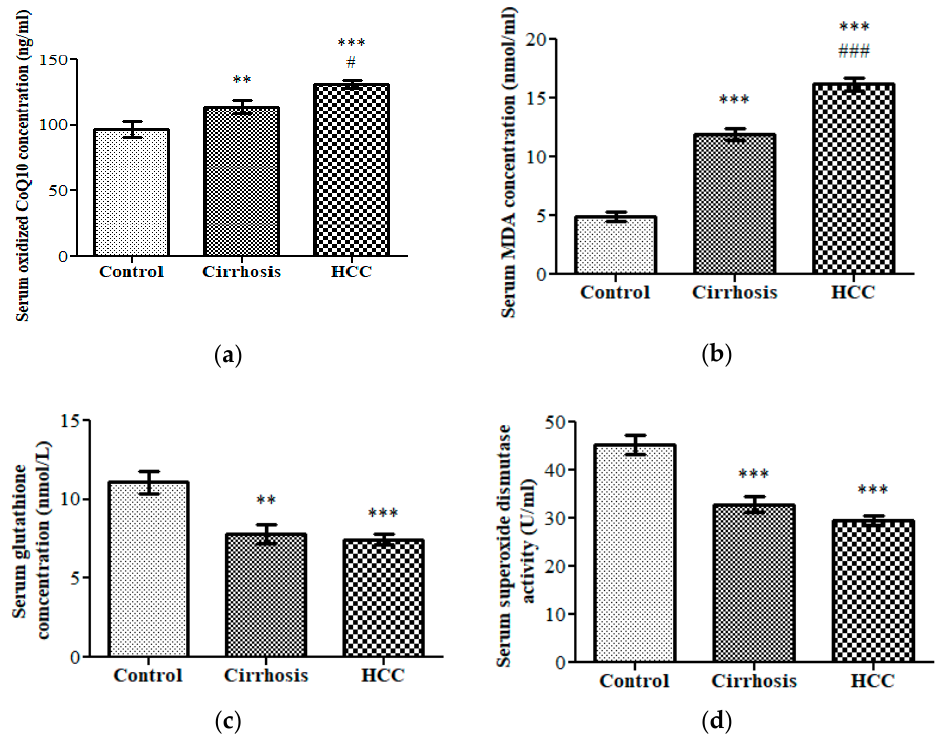
Figure 1. ( a ) Serum oxidized CoQ10 concentration (ng/mL) in cirrhotic, hepatocellular carcinoma (HCC) patients and control group; ( b ) Serum malondialdehyde (MDA) concentration (nmol/mL) in cirrhotic, HCC patients and control group; ( c ) Serum glutathione concentration (nmol/mL) in cirrhotic, HCC patients and control group; ( d ) Serum superoxide dismutase activity (U/mL) in cirrhotic, HCC patients and control group. One way ANOVA followed by Turkey post hoc test was used. Values were expressed as the mean ± standard error. ** = Significance against control group ( p < 0.01); *** = Significance against control group ( p < 0.001); # = Significance against cirrhotic group ( p < 0.05); ### = Significance against cirrhotic group ( p < 0.001).